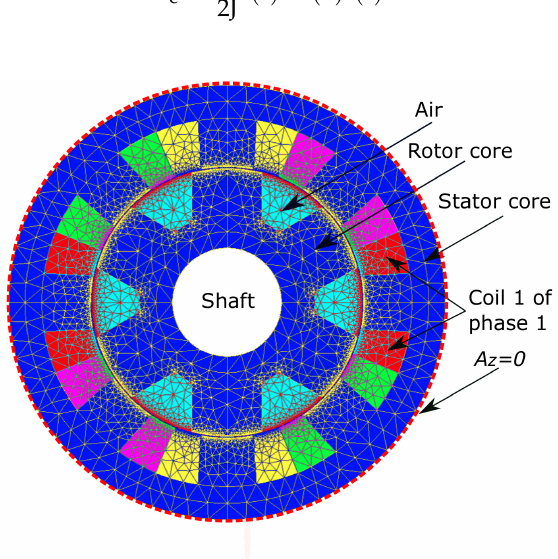
Figure 1. Geometry and mesh of the 8/6 switched reluctance motor